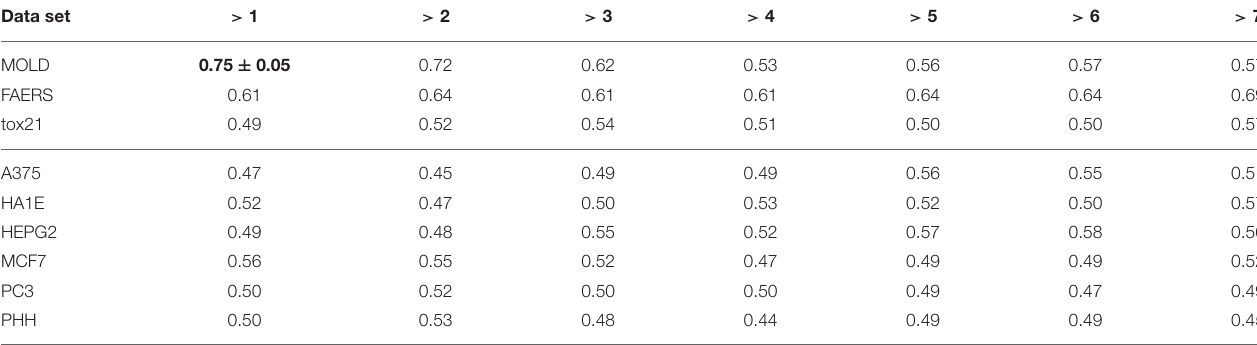
TABLE 5 | AUC for different binary decisions based on drug-induced liver injury (DILI) severity. Data set